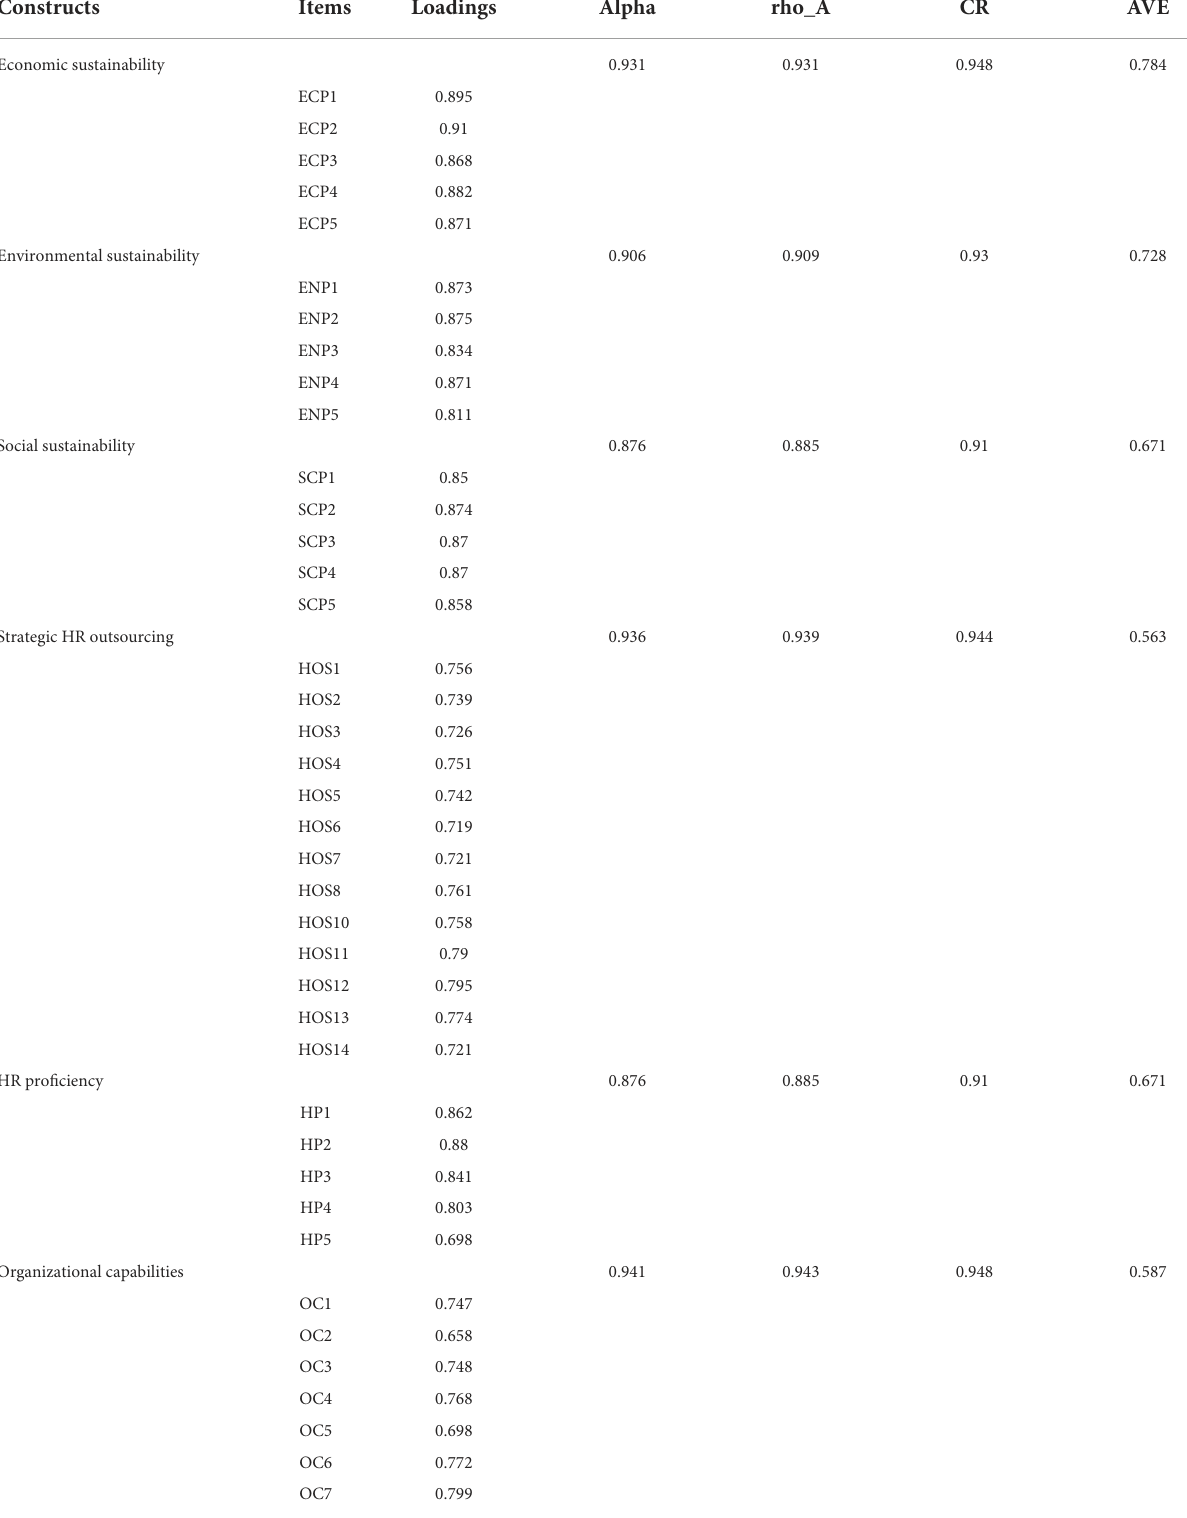
TABLE 3 Factor loadings cronbach alpha, composite reliability, and